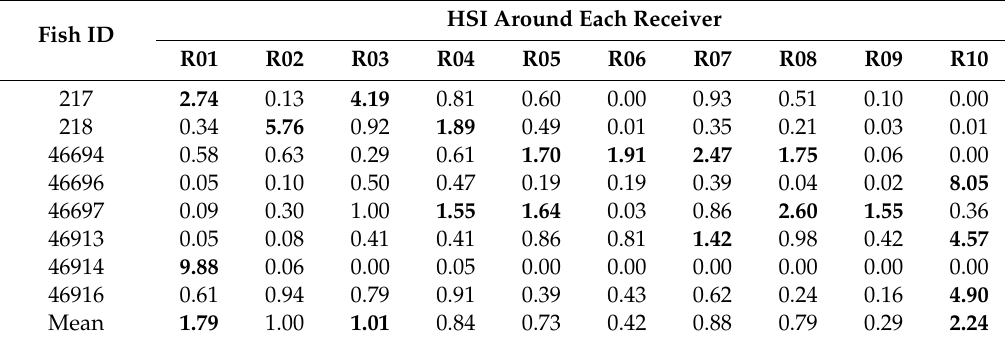
Figure 4. Spatial detection pattern and the calculated track routes for each fish in the West River with artificial fish nests (AFNs) and sand bar habitats. Table 4. Individual fish habitat selection index (HSI) for the habitats around each